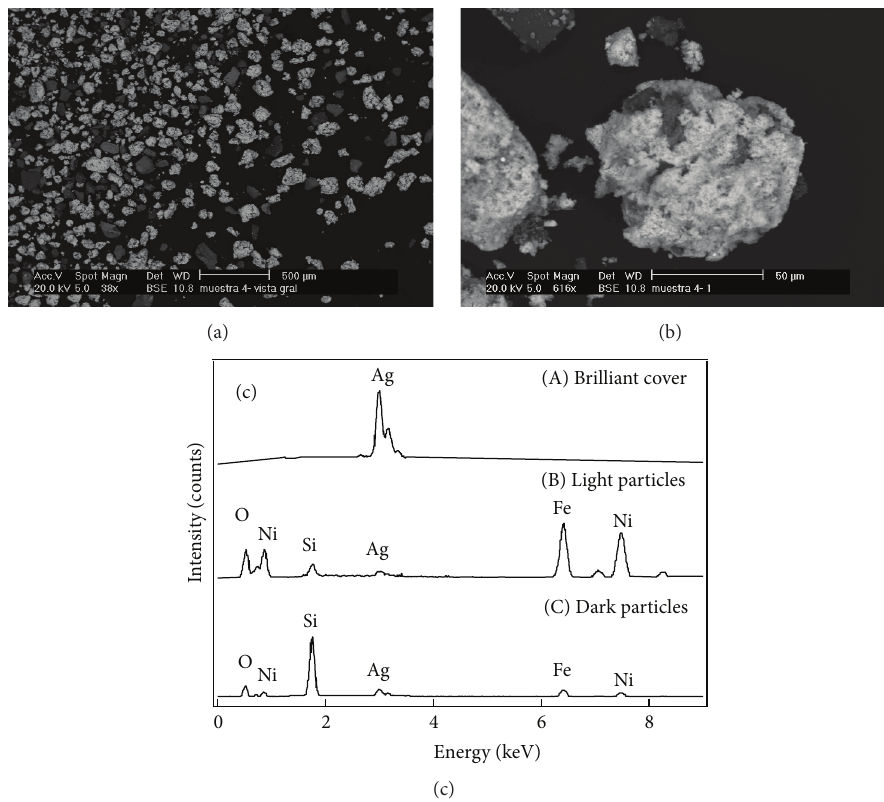
Figure 6: SEM micrographs of nickel ferrite-SiO 2 /Ag (a) and (b) and EDS of isolated aggregates